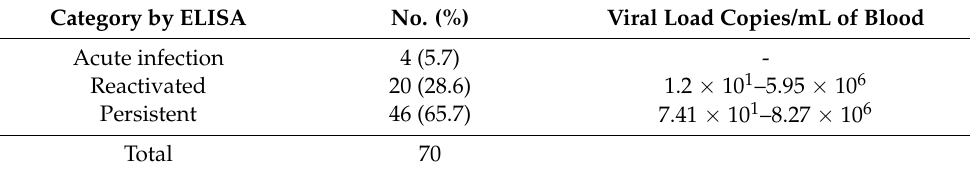
Table 4. B19 infection stages according to ELISA and qPCR ( n = 70).